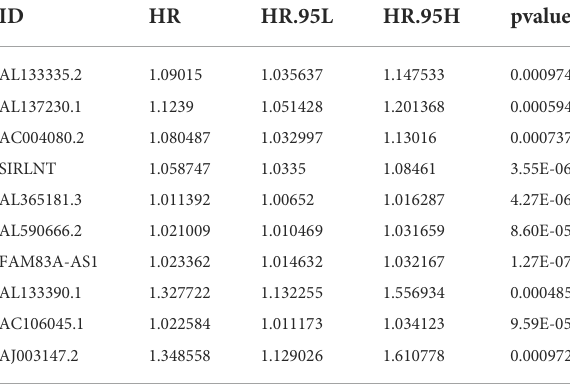
TABLE 1 Univariate Cox regression analysis of Nets-related